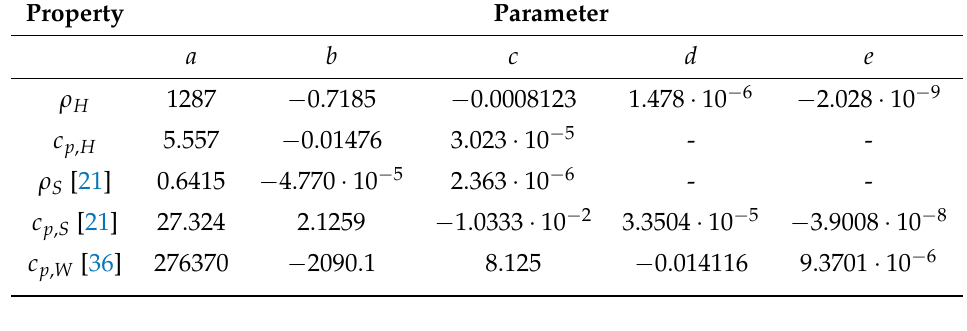
Table A1. Parameters of the temperature-dependent properties functions.